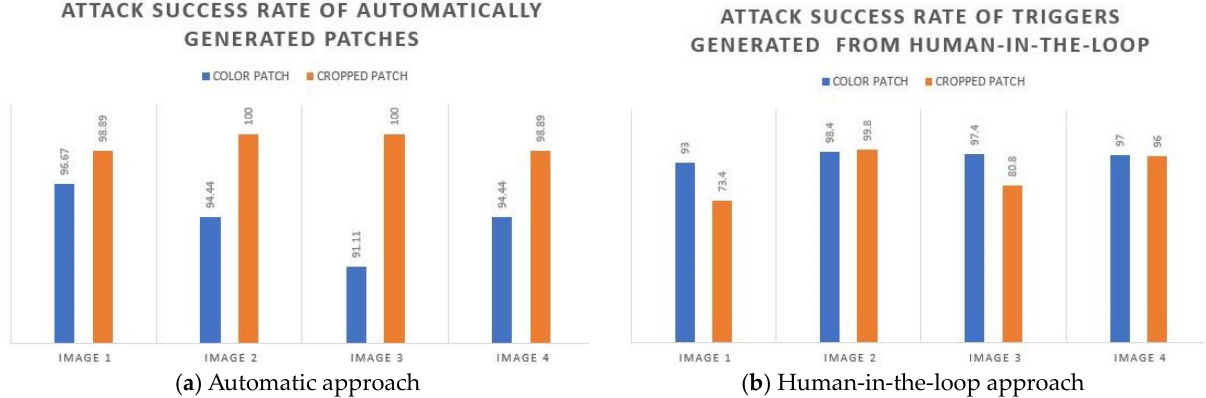
Figure 6. The comparison of the attack success rate of patches generated by automatic and human-in-the-loop approaches.